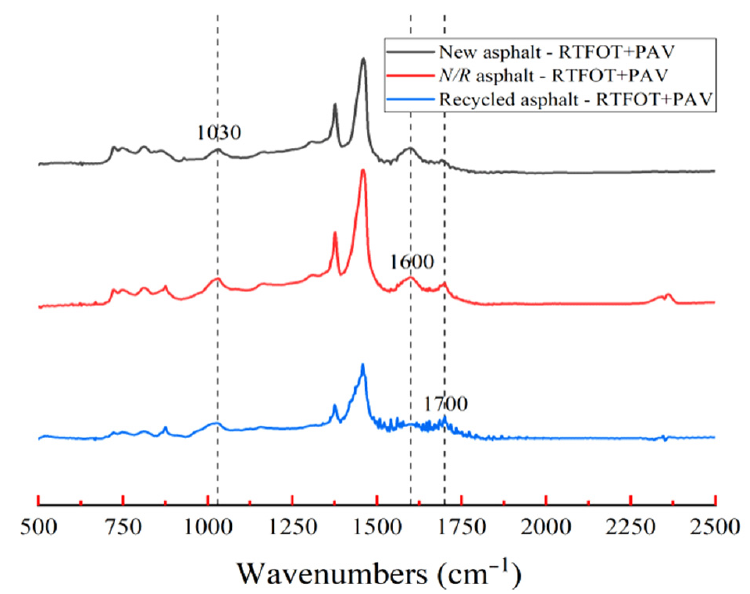
Figure 4. Infrared spectra of three asphalts after RTFOT and PAV aging.